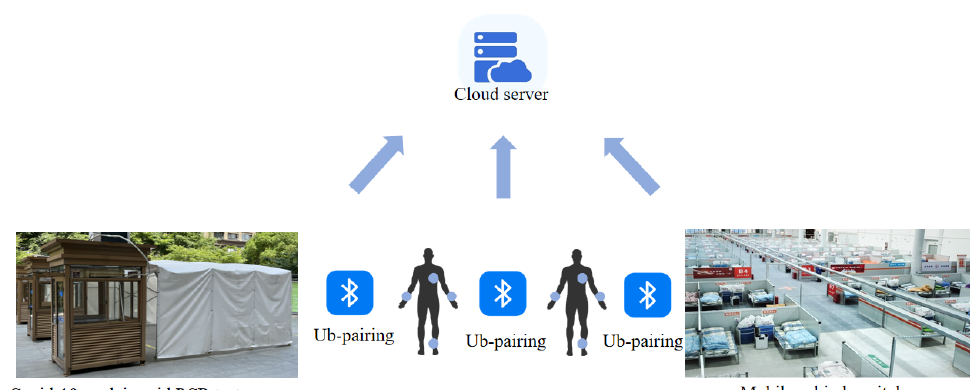
Figure 7. Use case.